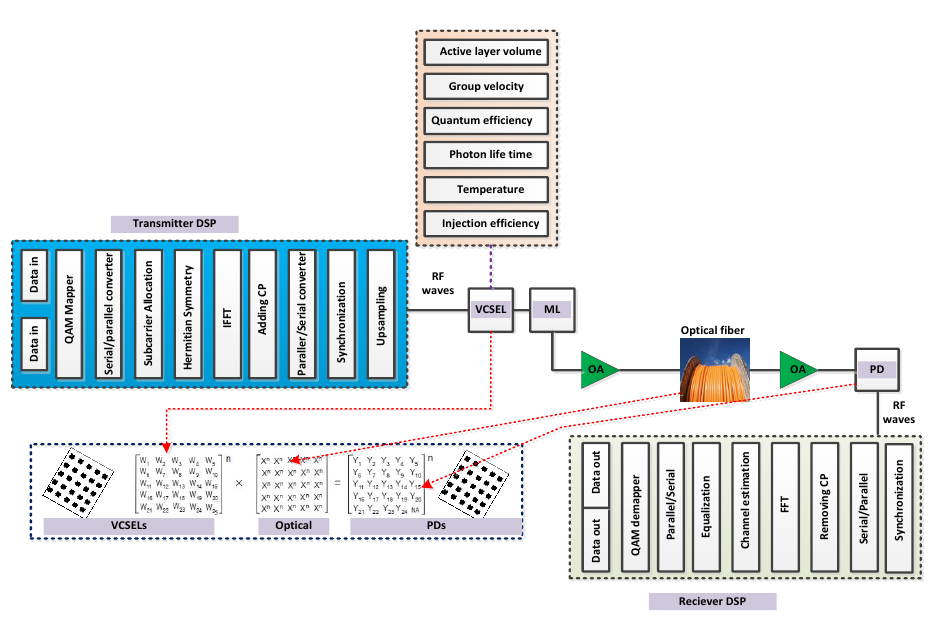
Figure 2. OWN structure using VCSEL-based ML for high data rate and multi-channel transmission. The properties such as the high directional beam and the narrow band of the VCSEL array have made for a fruitful optical source for high-capacity OWN. In this paper, the suggested VCSEL-based ML optical source is applied to the proposed OWN as depicted in Figure 2. The VCSEL attains data input data from the transmitter-based digital signal processing (DSP) block, including all the required procedures. The carrier number and photon density of transmitted optical signal is estimated [21–23] as